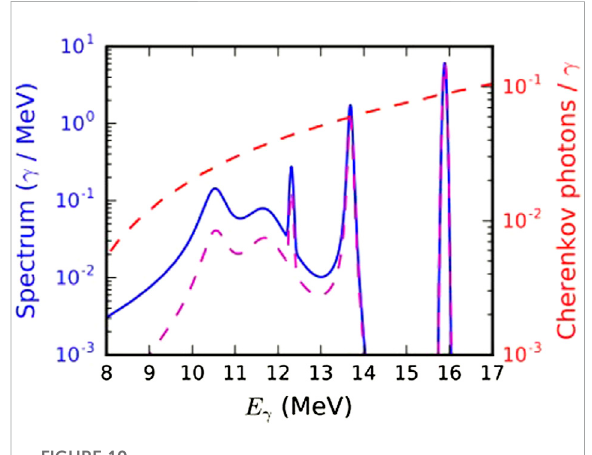
FIGURE 10 Gamma spectrum produced by the reaction T( 3 He, γ ) 6 Li. The blue line shows the spectrum while the red dotted line shows the GCD response relevant to this experiment. The magenta dotted line shows the sensitivity-normalized spectrum. Plot originally published in Ref. 9 and reproduced with permission of the corresponding author. Copyright 2016 by The American Physical Society.